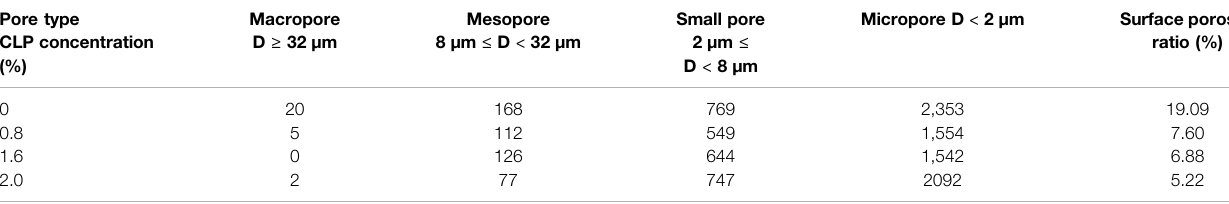
D indicates the diameter.